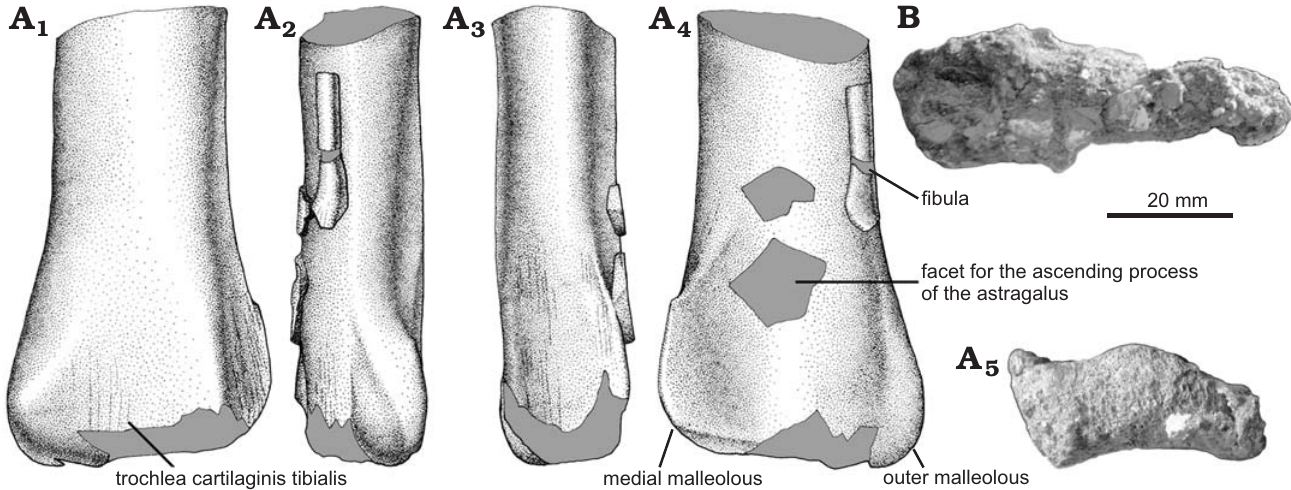
Fig. 5. A . Unenlagiid theropod Neuquenraptor argentinus Novas and Pol, 2005 (MCF PVPH 77) from Sierra del Portezuelo, Neuquén Province, Argentina; Portezuelo Formation, Coniacian, Late Cretaceous; distal end of the left tibia and fibula in caudal (A 1 ), lateral (A 2 ), medial (A 3 ), cranial (A 4 ), and distal (A 5 ) views. B . Unenlagiid theropod Unenlagia comahuensis Novas and Puerta, 1997 (MCF PVPH 78) from Sierra del Portezuelo, Neuquén Province, Argentina; Portezuelo Formation, Coniacian, Late Cretaceous; tibia in distal view. A 1 –A 4 , drawings; A 5 , B photographs.